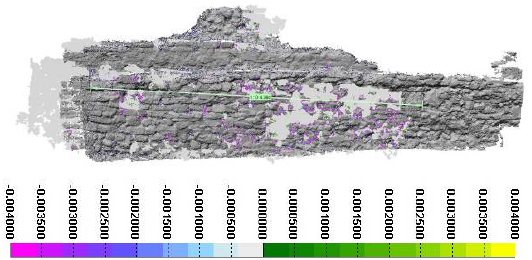
Figure 7. The comparison [m] between the mesh derived with Agisoft and the one from VisualSfM.